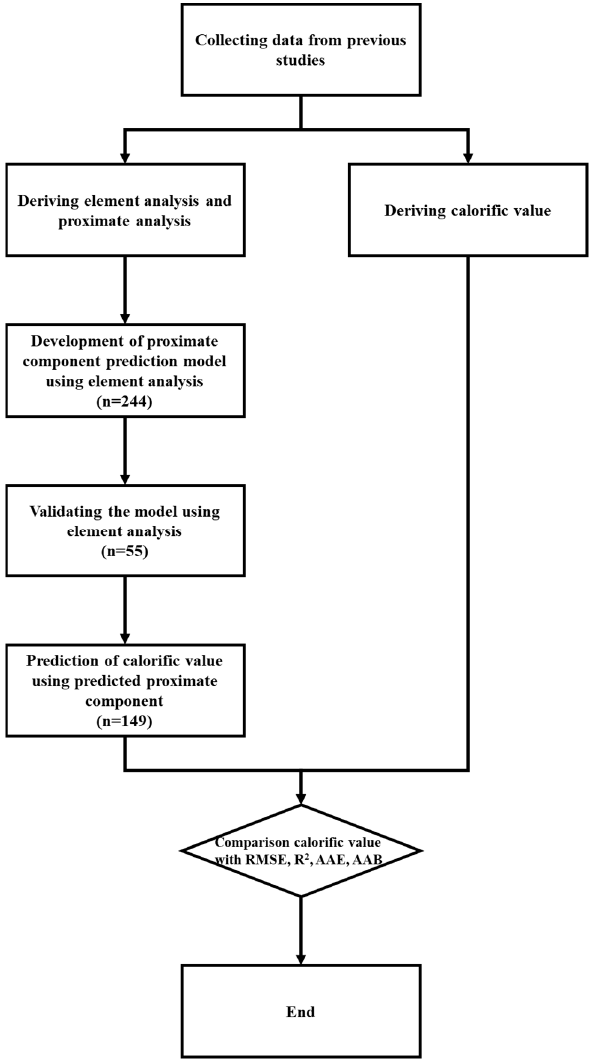
Figure 1. Flow chart depicting the stepwise progression of this study.